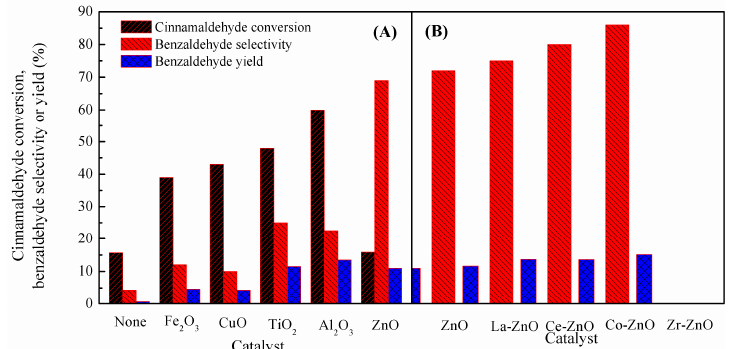
Figure 1. The catalytic oxidation of cinnamaldehyde on metal oxides ( A ) and transition metal modified ZnO ( B ). Reaction conditions: 0.01 g ZnO (or other catalysts) calcined at 400 °C for 2 h as a catalyst, 8.0 g ethanol and 2.0 g cinnamaldehyde reacted at an oxygen pressure of 1.0 MPa and 70 °C for 60 min.